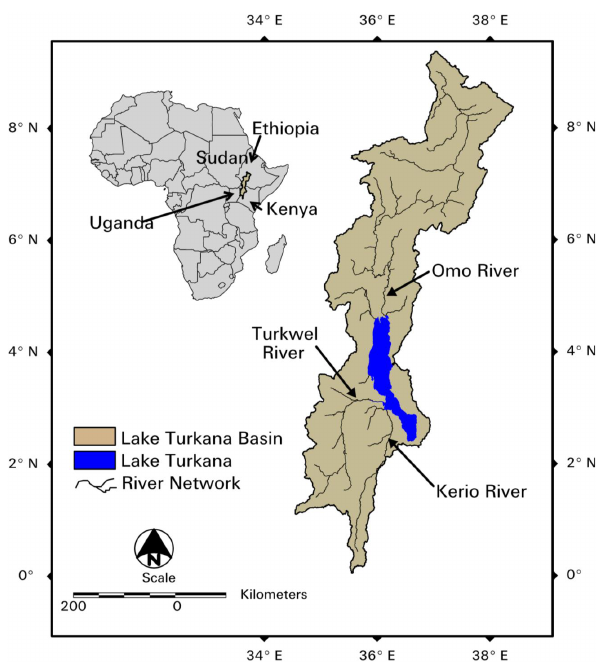
Fig. 1. Map of the study area showing spatial extent of the Lake Turkana basin in East